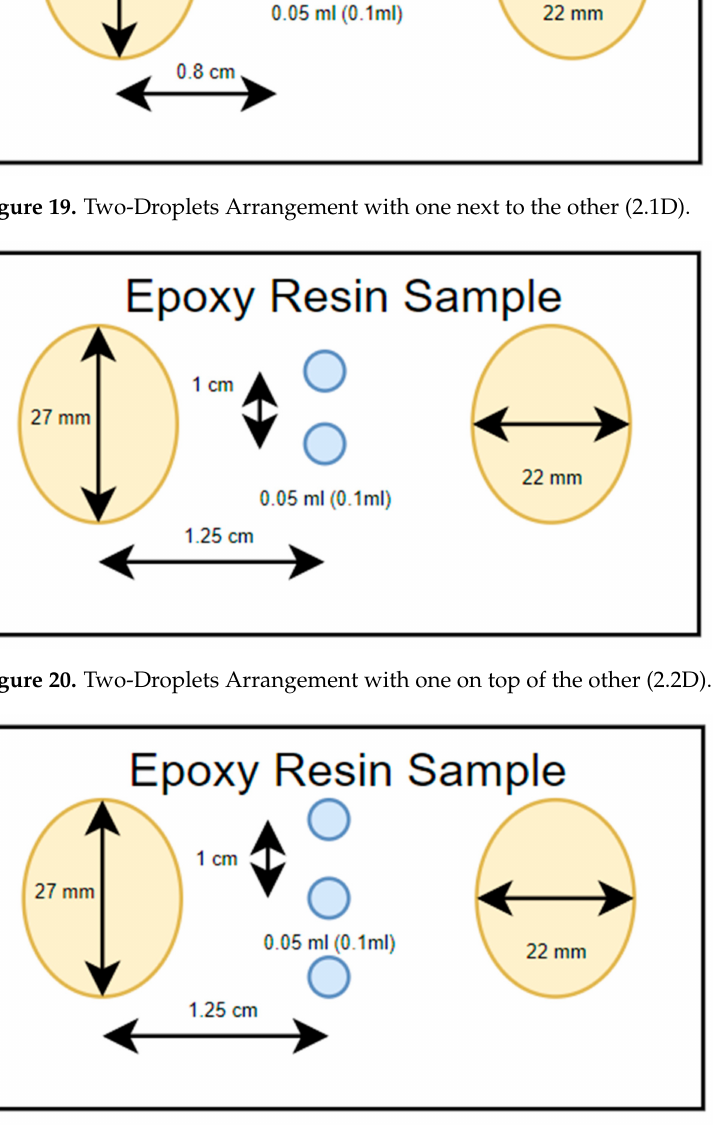
Figure 21. Three-Droplet Arrangement